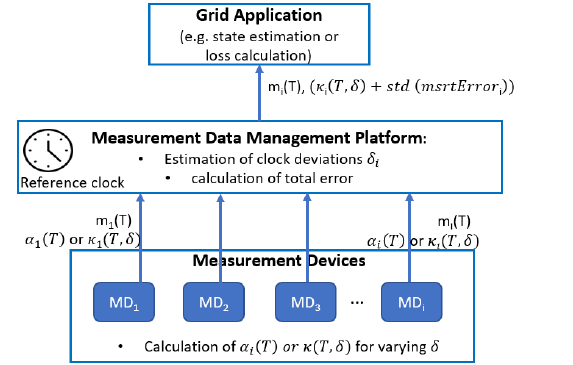
Figure 3. Calculation of time alignment errors by Data Management Platform of Distribution System